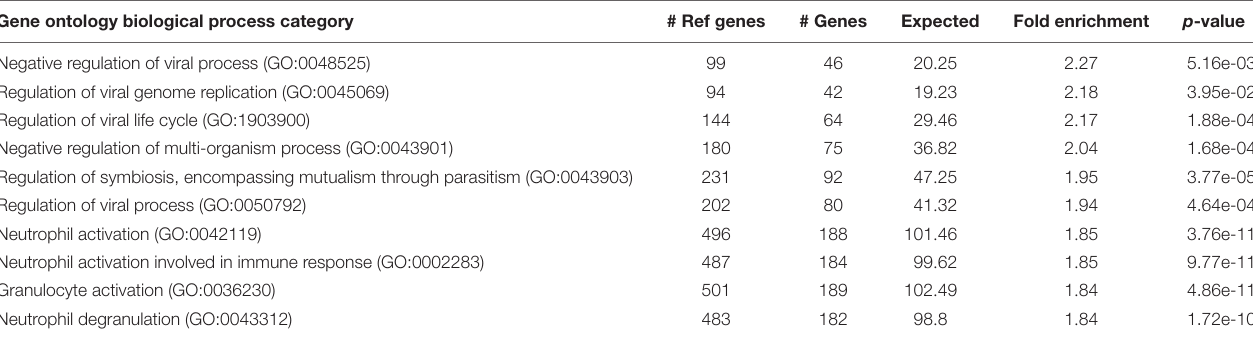
TABLE 5 | Top 10 identified gene ontology categories from PANTHER overrepresentation test of our eQTL analysis results, according to fold enrichment. Gene ontology biological process category # Ref genes # Genes Expected Fold